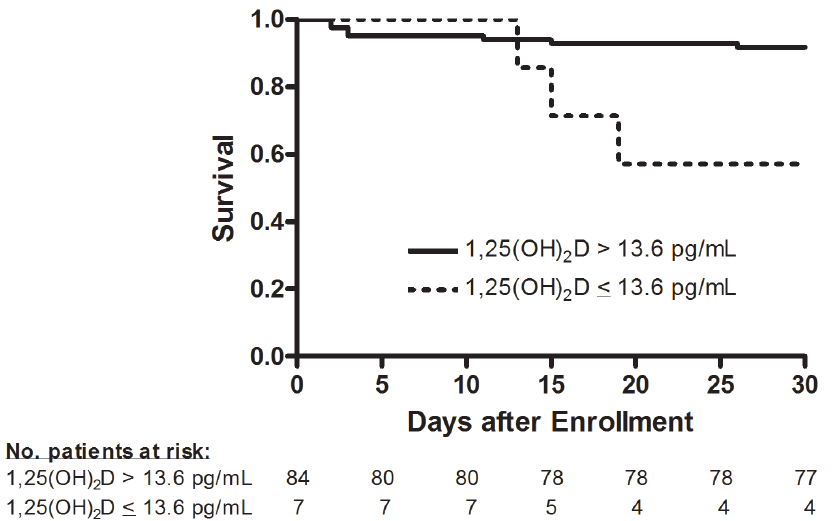
Figure 2. Kaplan Meier survival analysis between patients with mean 1,25-dihydroxyvitamin D (1,25(OH) 2 D) , vs. . 13.6 pg/mL measured over the 72-study period. The mean survival time for patients with 1,25(OH) 2 D , 13.6 pg/mL was 17.6 days, compared to 24.6 days in patients with 1,25 (OH) 2 D level . 13.6 pg/mL (p , 0.01).